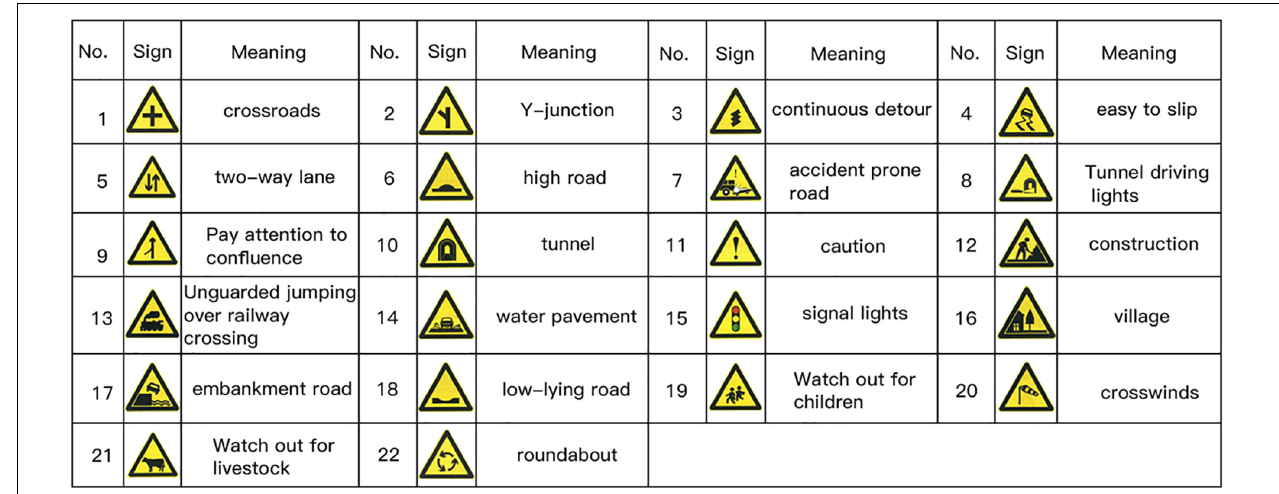
FIGURE 4 | 22 traffic warning signs with an understanding rate of 67% or